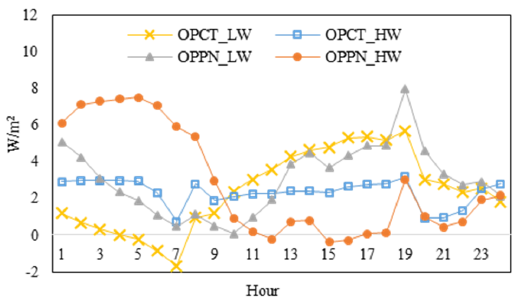
Figure 14. Conduction heat gains on the inside faces of external walls in north perimeter zones with ESCS on Beijing cooling design day.